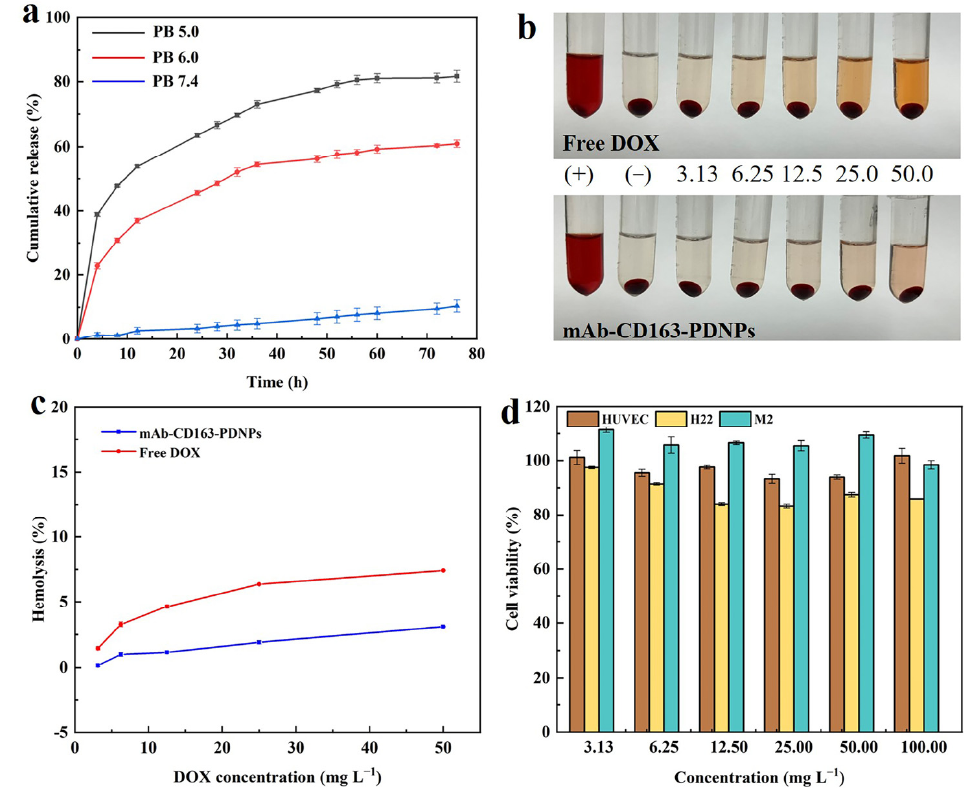
Figure 4. ( a ) DOX release curves of mAb-CD163-PDNPs in PB 5.0, PB 6.0, and PB 7.4, respectively. ( b ) Photos of red blood cells incubated with free DOX and N 3 -PEG- b -(PFBEMA-DOX) for 5 h (after centrifugation). PBS ( − ) and ultrapure water (+) as negative and positive controls, respectively. The numbers in the middle of the two pictures represent the concentrations of DOX. ( c ) Hemolysis percentage of samples at different DOX concentrations. ( d ) Cell viability of HUVEC, H22, and M2-type macrophages after being incubated with N 3 -PEG- b -PFBEMA at different concentrations for 48 h.